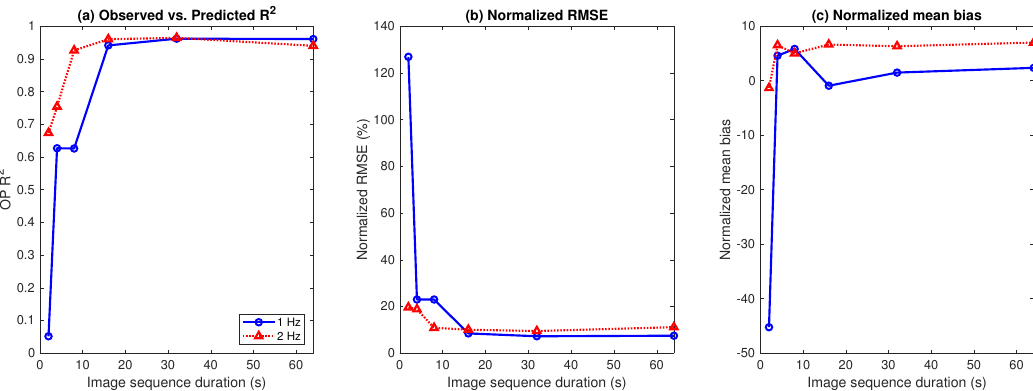
Figure 10. Sensitivity of the accuracy of PIV-derived velocities to image sequence duration for the Tanana River for a fixed interrogation area of 128 pixels and frame rates of 1 and 2 Hz. OP = Observed (ADCP) vs. Predicted (PIV). The RMSE and mean bias are normalized by the reach-averaged mean velocity recorded by the ADCP: 1.78